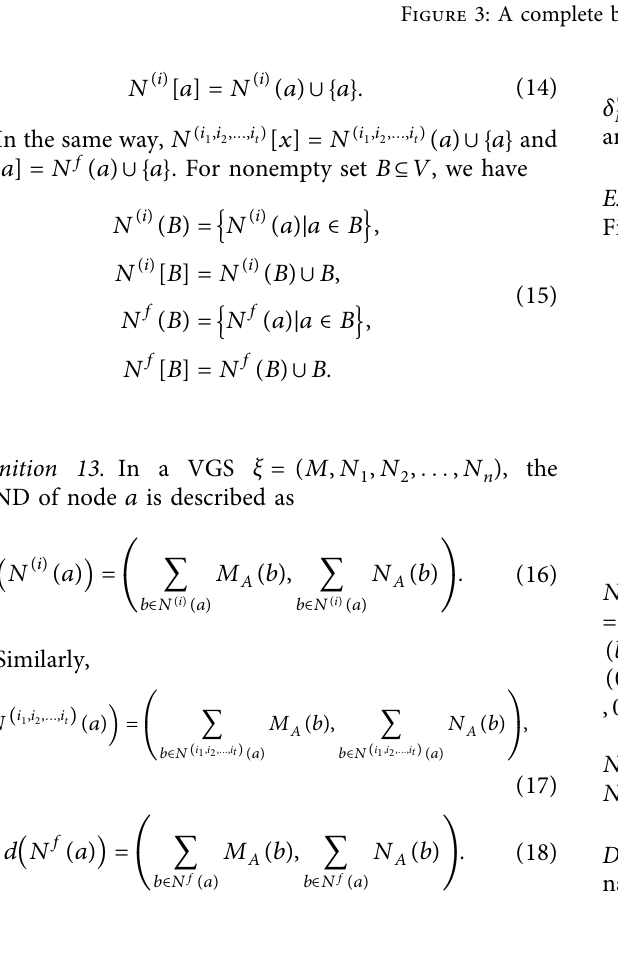
Figure 3: A complete bipartite VGS ξ